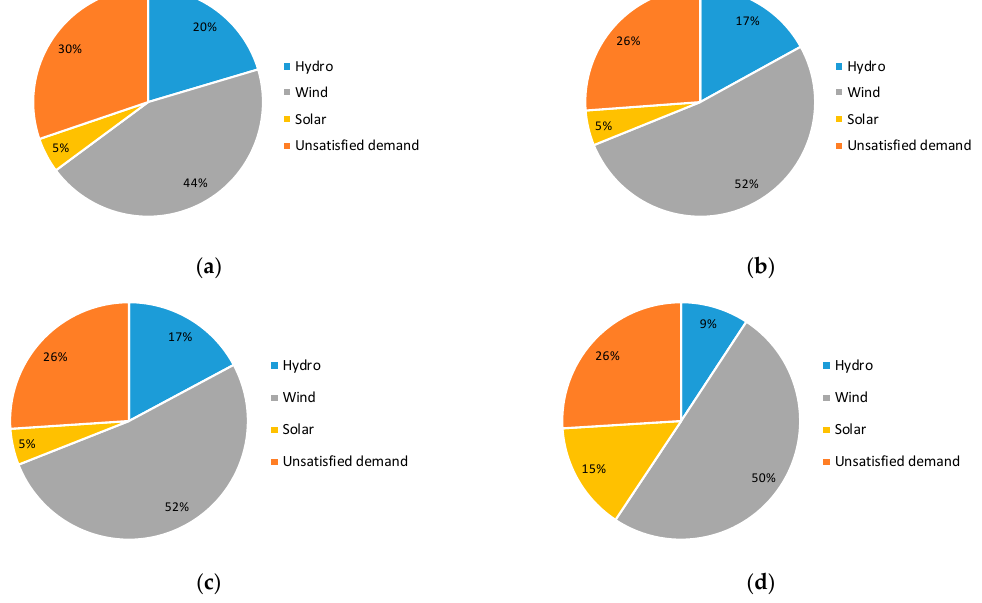
Figure 16. Satisfied consumption by different energy sources and unsatisfied consumption in ( a ) scenario 1; ( b ) scenario 2; ( c ) scenario 3; ( d ) scenario 4.